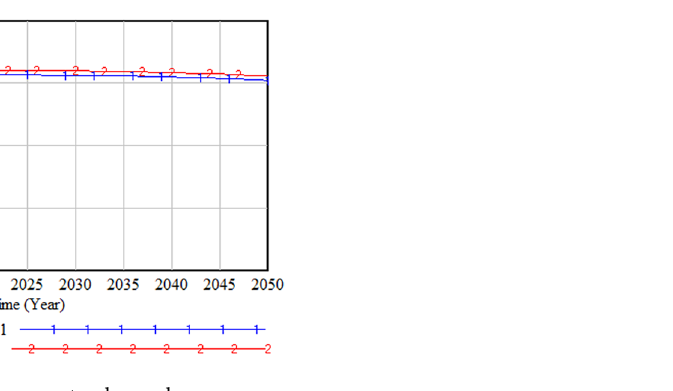
Figure 29. Impact of heat waves on water